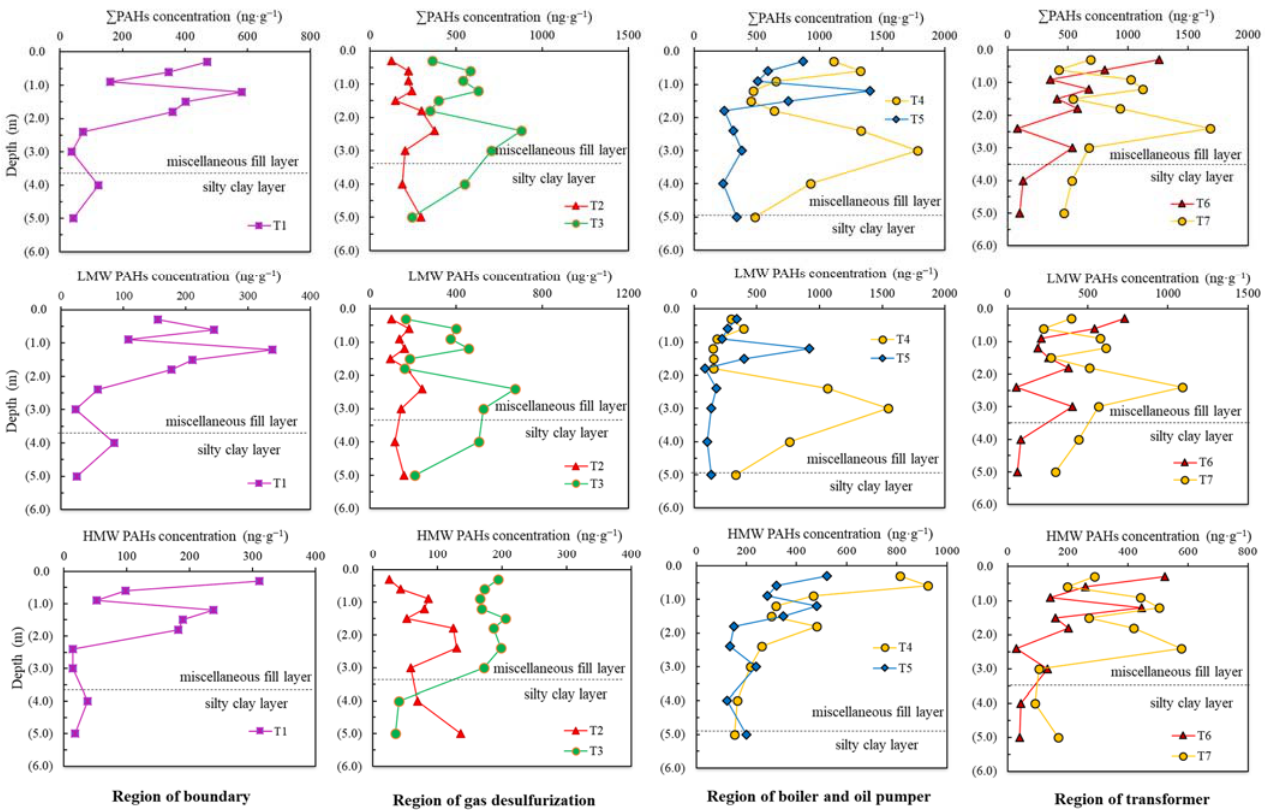
Figure 2. Longitudinal distribution of PAH in each sampling core related to former production unit of the coal-fired power plant; the dividing line indicates the approximate boundary of soil lithology.